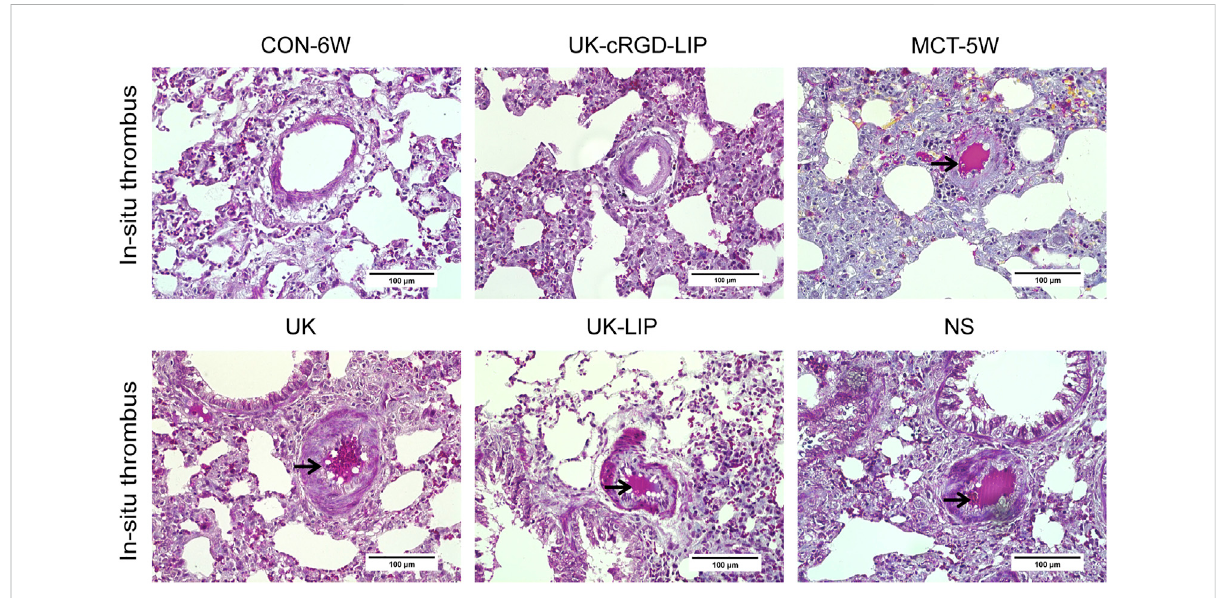
FIGURE 5 Representative images(×400originalmagni fi cation)of fi brinstaining(modi fi edMSBmethod)oflungtissuesfromCON-6W,MCT-5W,UK,UK- LIP,NS,andUK-cRGD-LIPrats.Redindicates fi brindeposition;yellowindicateserythrocyteaccumulation.Blackarrowpointstointravascular in-situ thrombus.